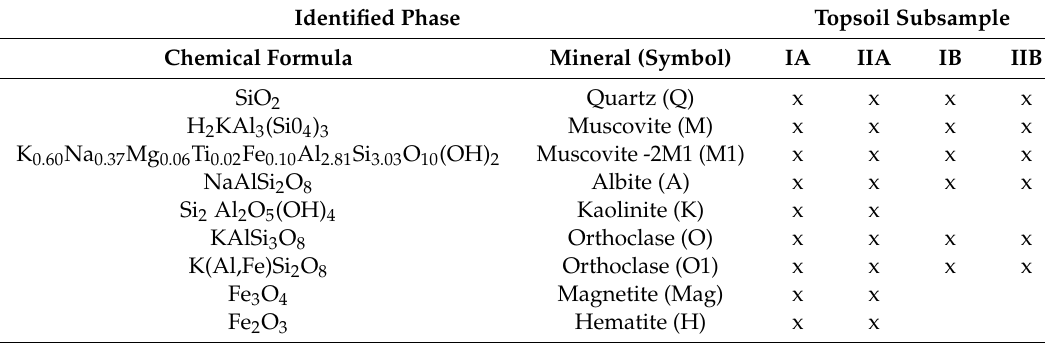
Figure 1. The X-ray diffraction patterns of topsoil subsamples IA, IB, IIA and IIB. Table 2. The identified phases in topsoil subsamples after sieve and magnetic separation (presence of particulate phases in sample was marked as “x”).